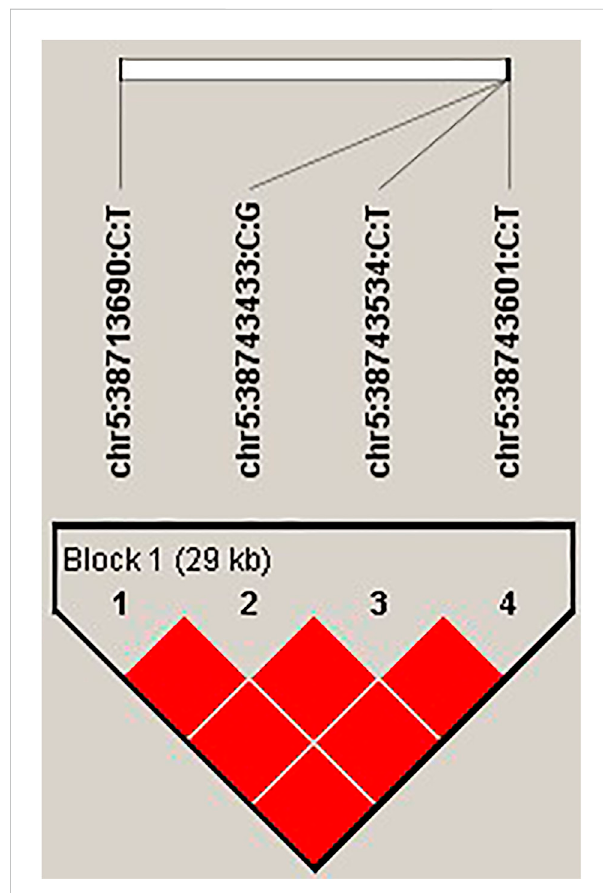
FIGURE 4 Four top SNPs within the intron of the gene STARD9 within a haplotype block. Linkage disequilibrium and haplotype block of the gene STARD9 was estimated using Haploview 4.1 software (Barrett et al., 2005) based on con fi dence intervals (Gabriel et al., 2002). Frequency of haplotype CCCC was 0.933. Frequency of haplotype TGTT was 0.067.